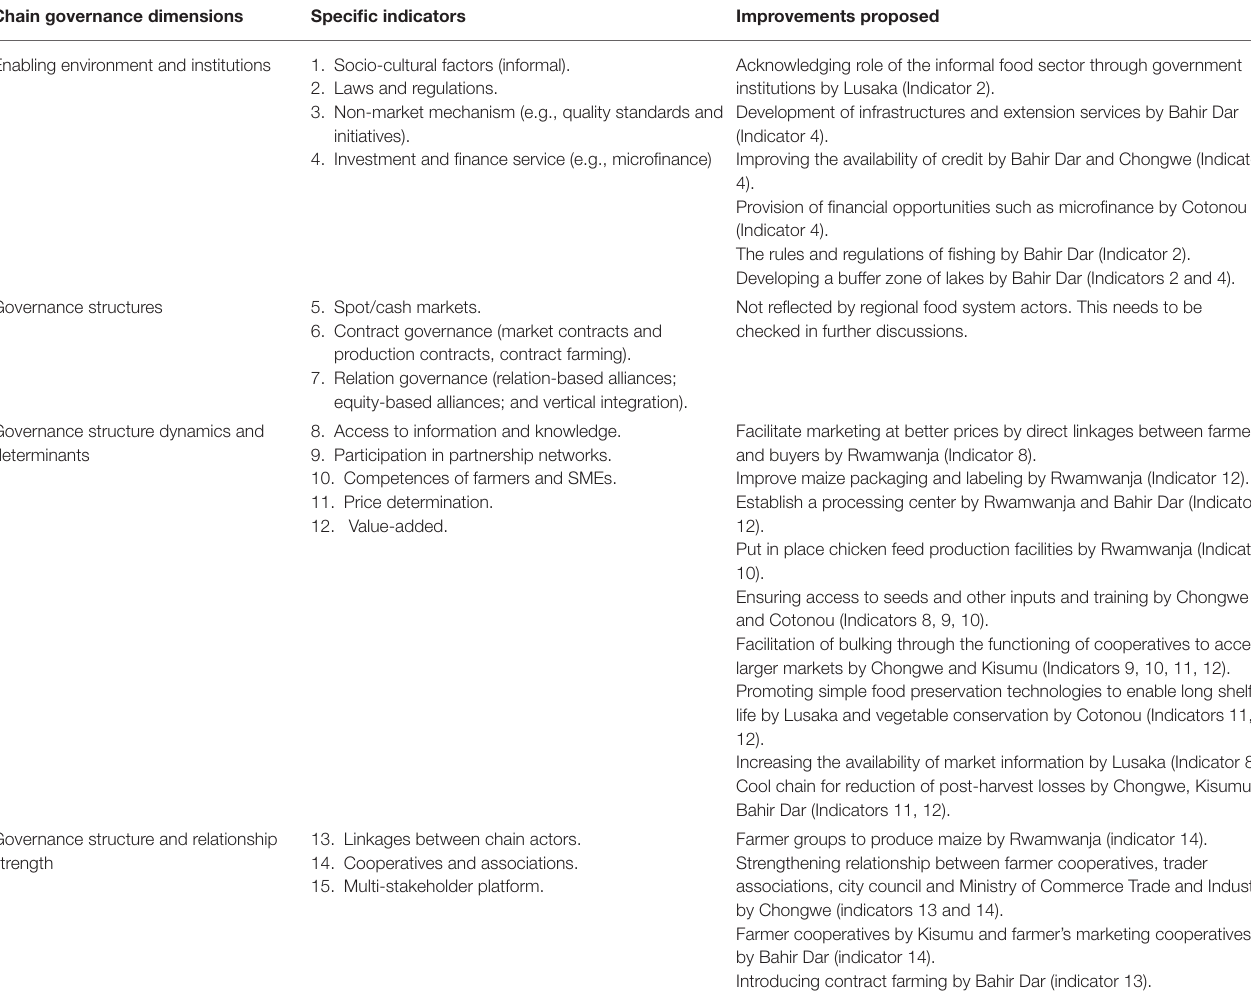
TABLE 6 | Comparison of assessment criteria with the food chain governance improvements proposed. Chain governance dimensions Specific